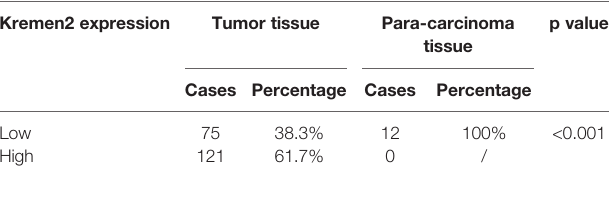
TABLE 1 | Expression patterns in gastric cancer tissues and adjacent normal tissues revealed in immunohistochemistry analysis. Kremen2